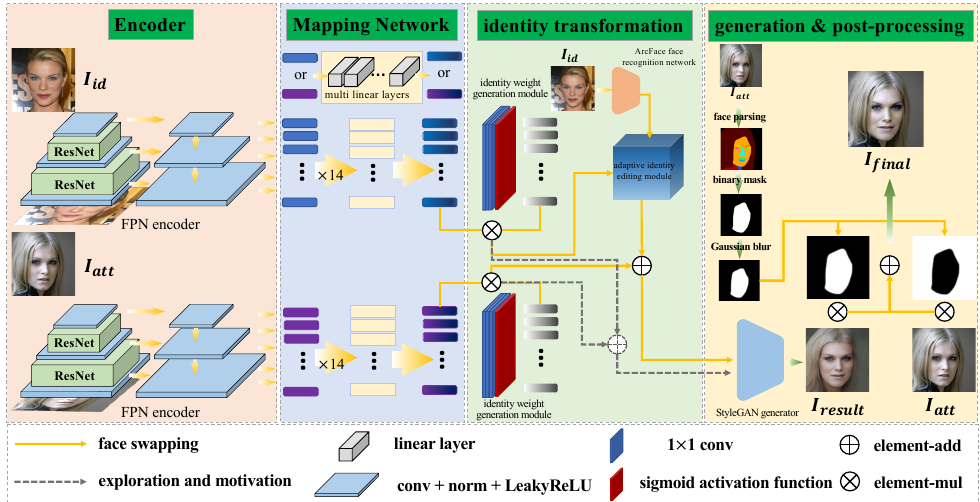
Figure 2. The overall structure of the network, which is composed of feature pyramid network with ResNet, mapping network, identity weight generation module, adaptive identity editing module, generator, and post-processing